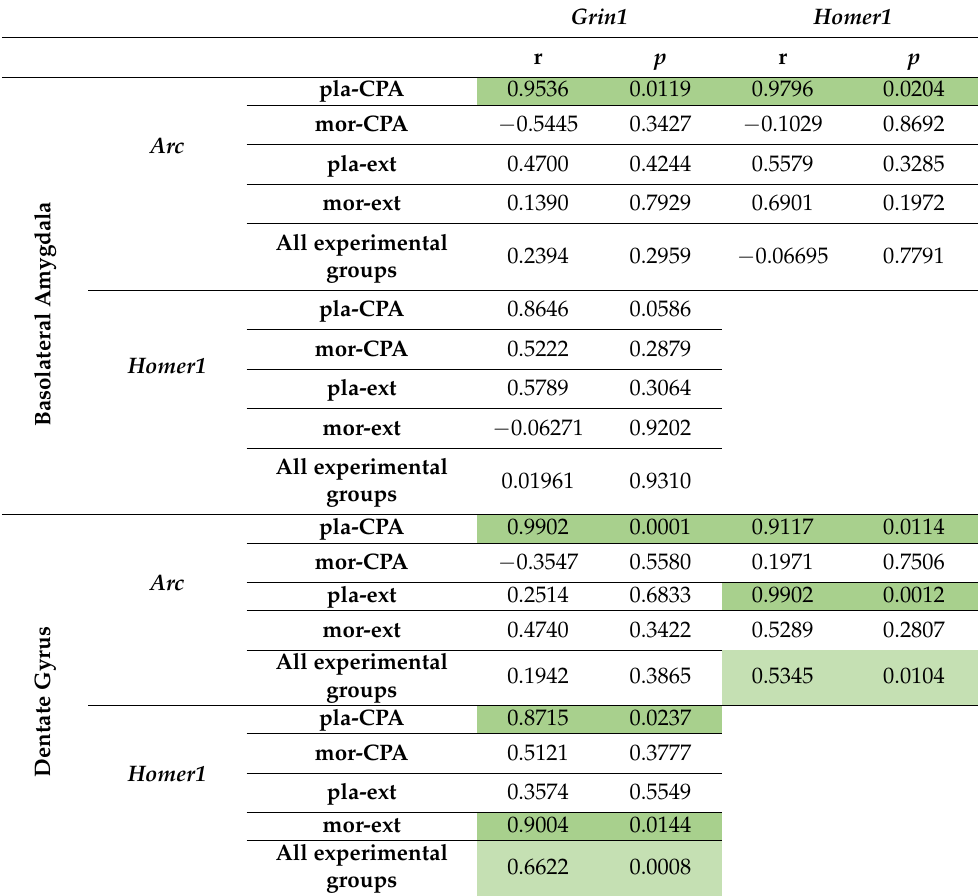
Table 4. Correlations between Arc , Grin1, and Homer1 mRNA relative levels in the BLA and DG. Grin1